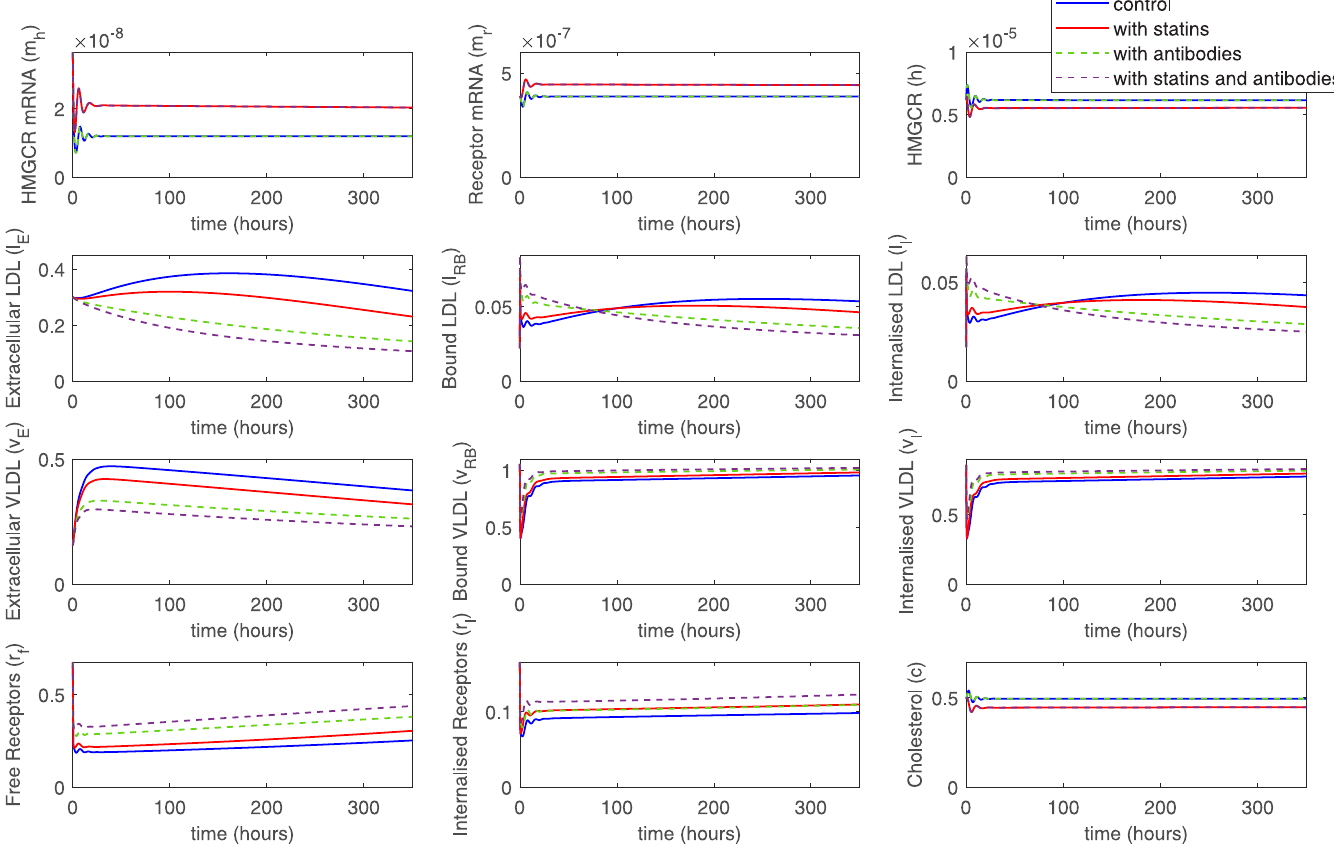
Fig 8. Combined therapy with statins and anti-PCSK9 agents might demonstrate additive effects on LDL and VLDL levels.